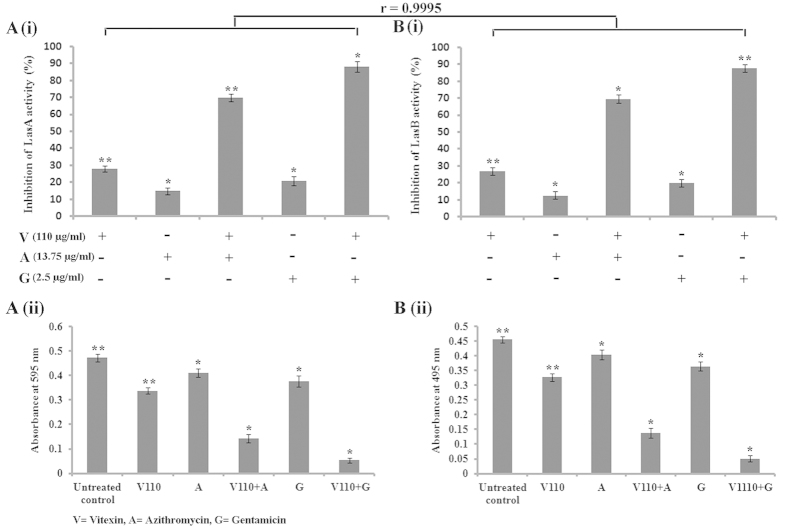
Effect of vitexin, combination of vitexin-azithromycin and vitexin-gentamicin on LasA and LasB activity of P. aeruginosa.After treatment LasA (A) and LasB (B) were estimated by UV-vis spectrophotometer from culture supernatant and expressed as percentage inhibition (with respect to untreated control) (A(i),B(i)) and absorbance values (A(ii),B(ii)).